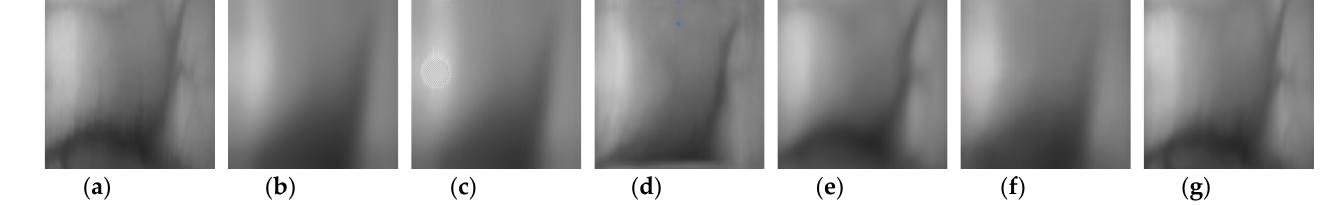
Figure 13. Examples of restored SDU-DB finger-vein images using the state-of-the-art methods and the proposed RMOBF-Net (motion blur with Gaussian blur filter of 15 × 15): ( a ) original image, ( b ) blurred image and images restored by ( c ) DeblurGAN, ( d ) DeblurGANv2, ( e ) SRN-DeblurNet, ( f ) MPRNet, and ( g ) RMOBF-Net.